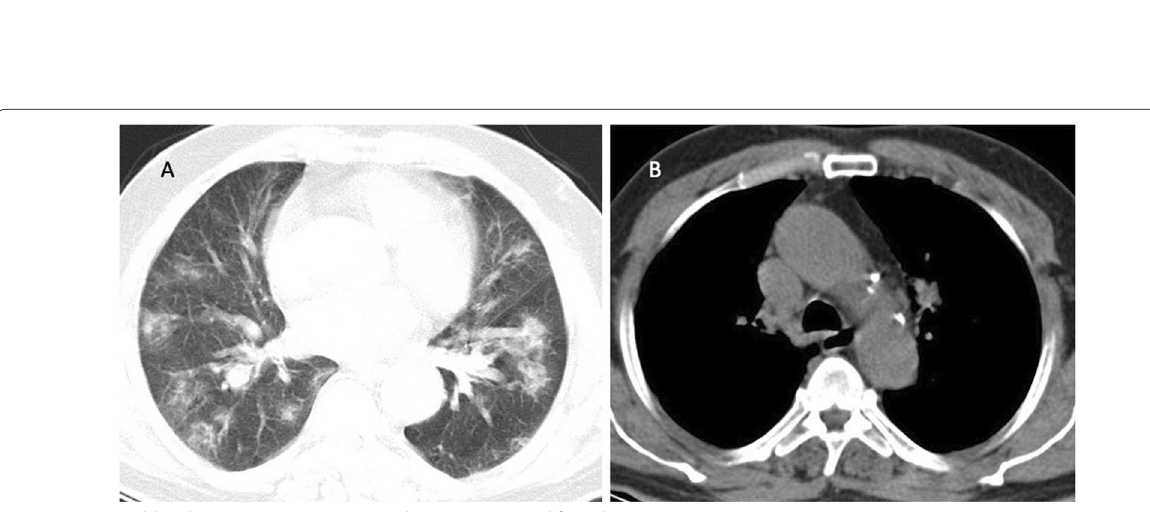
) patient with CT-SS 20 ( A ) and fatty thymus ( B +